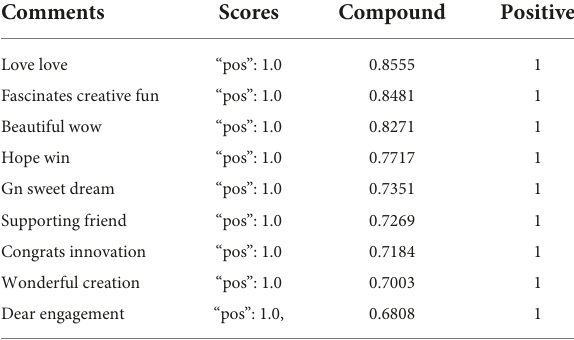
TABLE 5c Analysis results of positive attitude and content of related